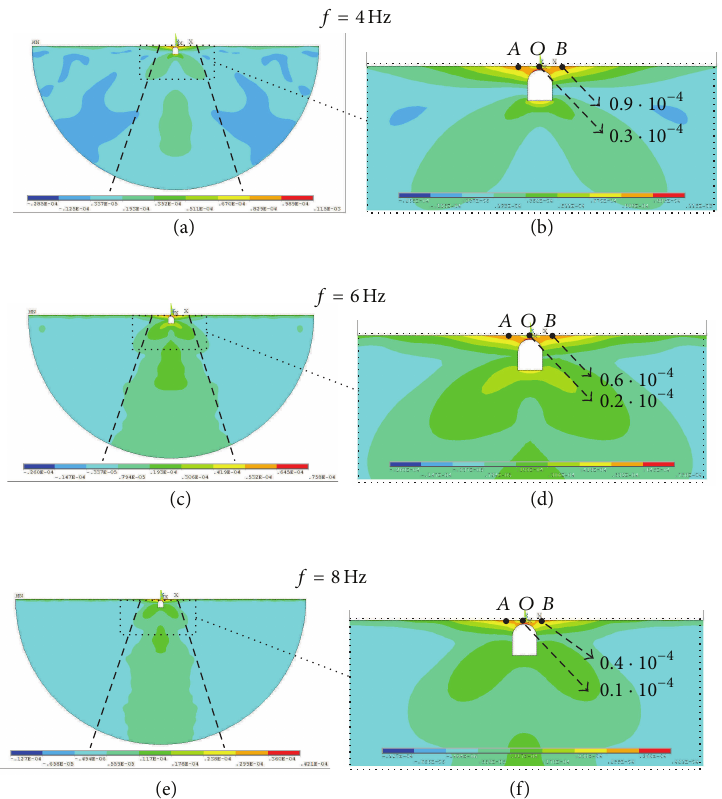
Figure 10: Absolute value of the horizontal scattered displacement, |̂𝑢 𝑠 1 | , for cave 3A at different values of the frequency 𝑓 .